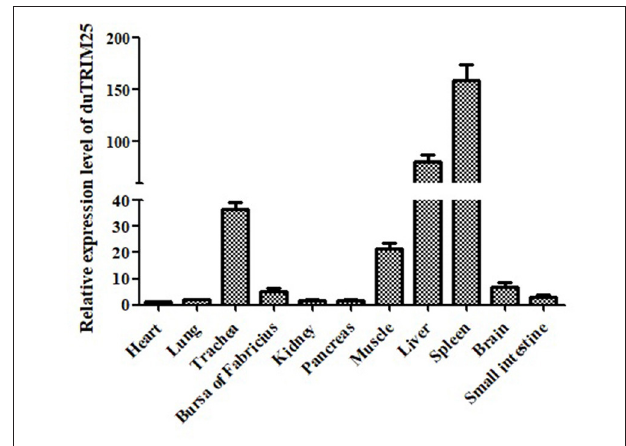
FIGURE 2 | Relative expression levels of duTRIM25 in healthy ducks. The transcription levels of duTRIM25 in different tissues were measured by quantitative real-time PCR. GAPDH was used as the control gene. Data were analyzed using GraphPad Prism software, and the results are means ± SD of three independent